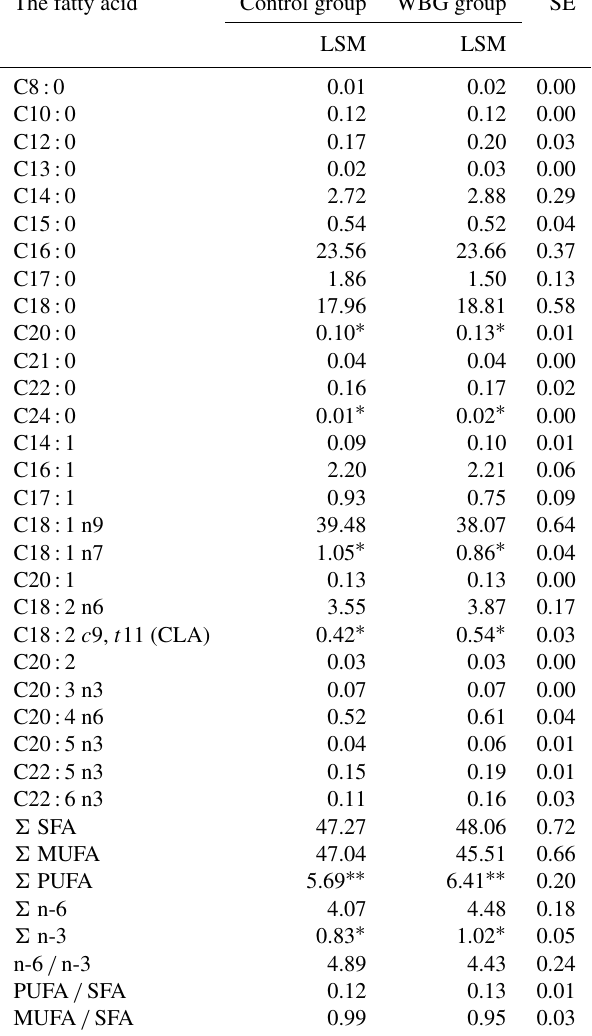
Table 7. The fatty acid composition in the meat of the control and WBG lambs (values in (mg/100g fat)). The fatty